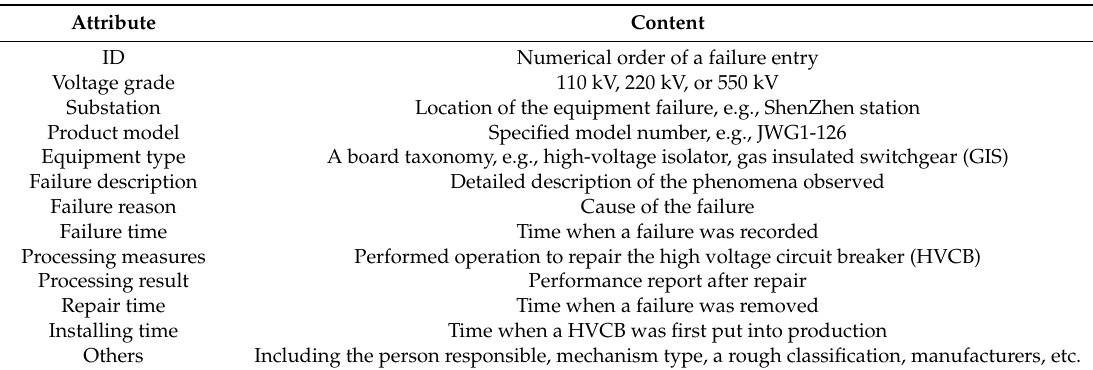
Table 1. Attributes of the failure logs.